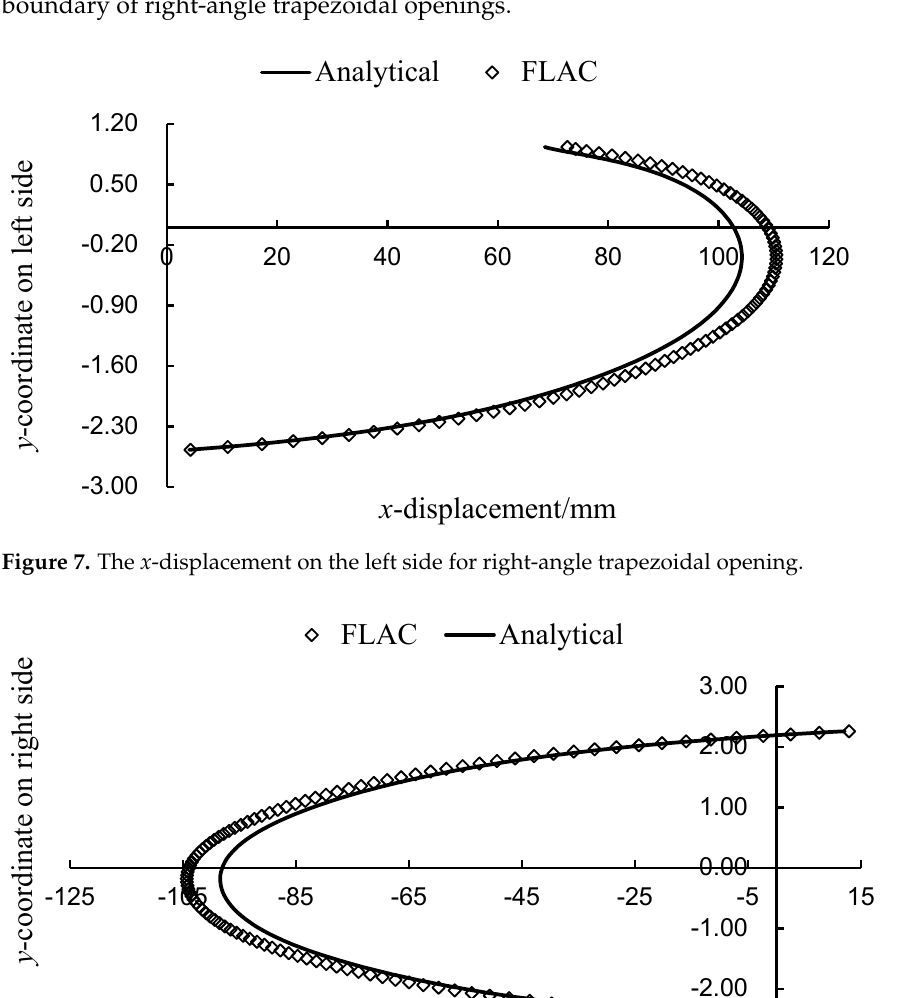
Figure 7. The x -displacement on the left side for right-angle trapezoidal opening. Figure 8. The x -displacement on the right side for right-angle trapezoidal Analytical